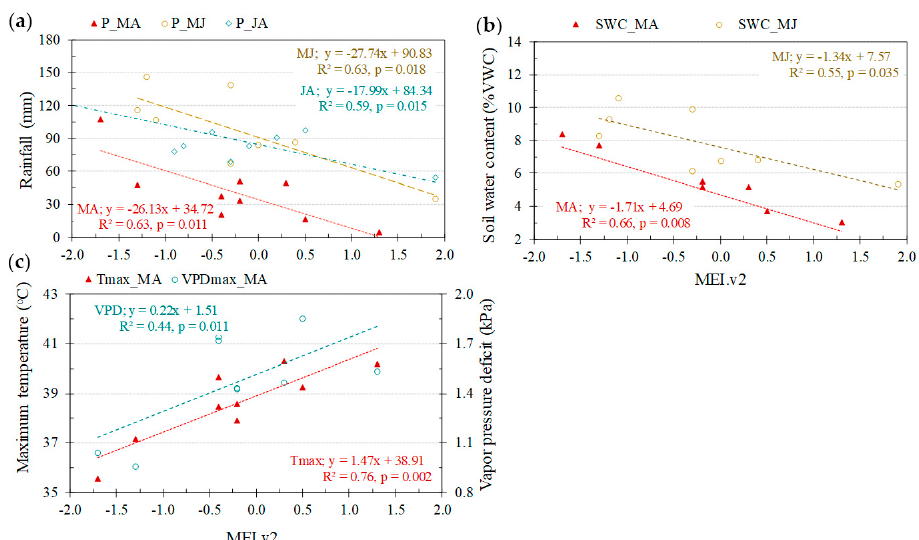
Figure 2. Relationships between Multivariate El Niño/Southern Oscillation (ENSO) index (MEI.v2) and microclimate variables consisting of ( a ) rainfall (P), ( b ) soil water content (SWC) and ( c ) maximum air temperature (Tmax) and maximum vapor pressure deficit (VPDmax) during March-April (MA), May-June (MJ) and July-August (JA) between 2009 and 2018.